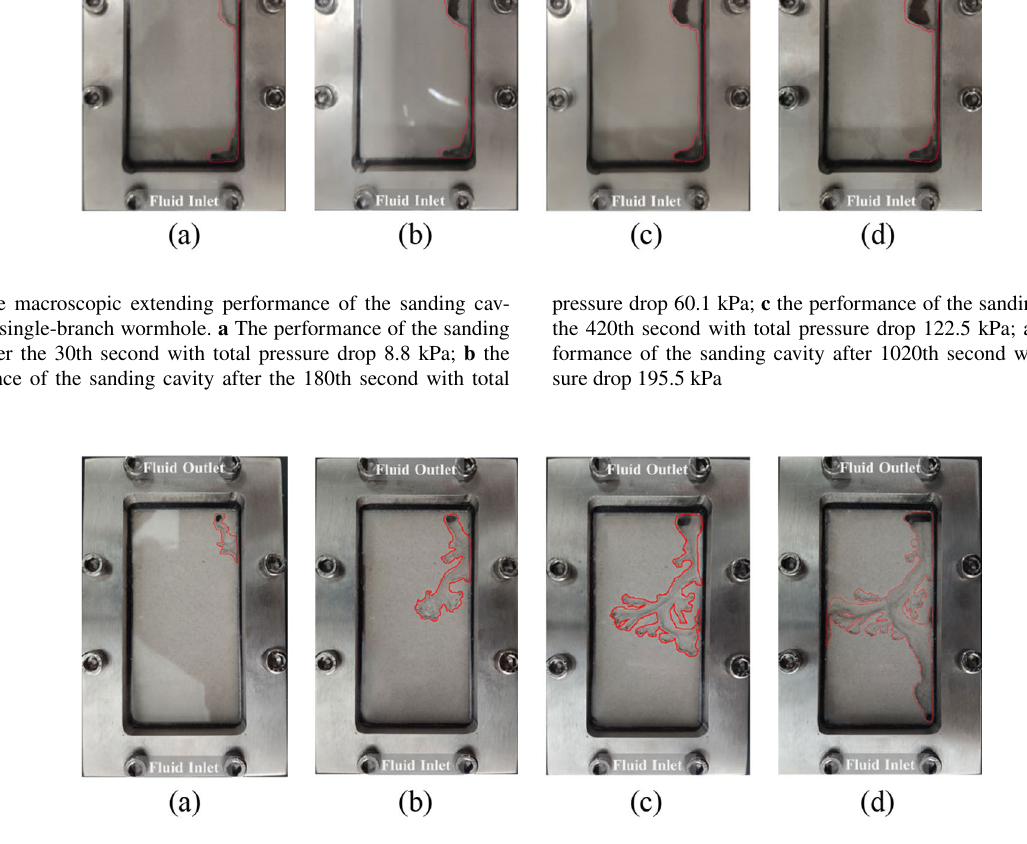
pressure drop 65.0 kPa; c the performance of the sanding cavity after the 218th second with total pressure drop 185.3 kPa; and d the per- formance of the sanding cavity after 1118th second with total pres- sure drop 360.7